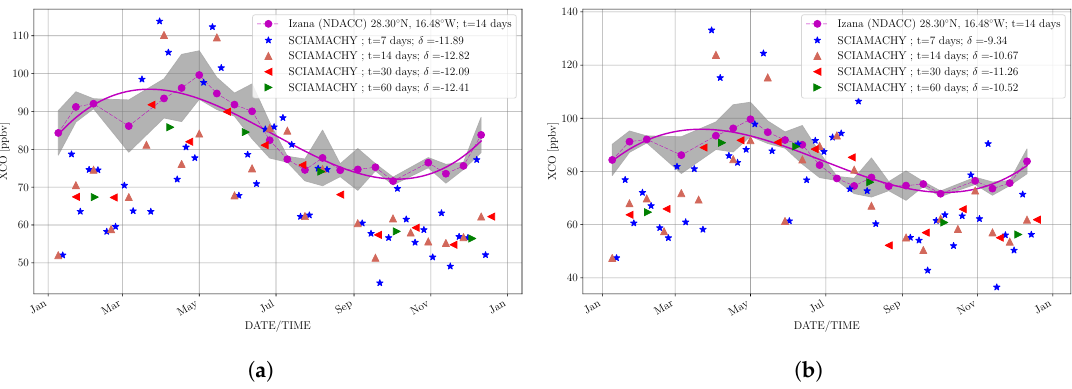
Figure 4. xCO averages for various temporal intervals within ( a ) 1000 km and ( b ) 500 km of Izana in 2003. δ designates the offset of the s-b averages to the 14-days mean of Izana. The gray shaded area and magenta solid line represent the standard deviation of the g-b means and the third-order polynomial fit on the individual observations, respectively. The SCIAMACHY xCO averages become smoother in larger temporal intervals and in the share of averages. This is in agreement within the standard deviation of the g-b site increases. Note the different range of the